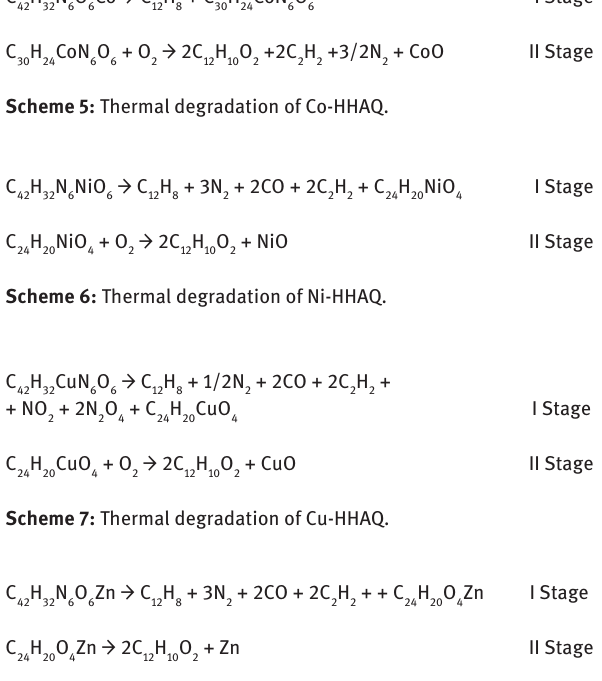
Scheme 5: Thermal degradation of Co-HHAQ.